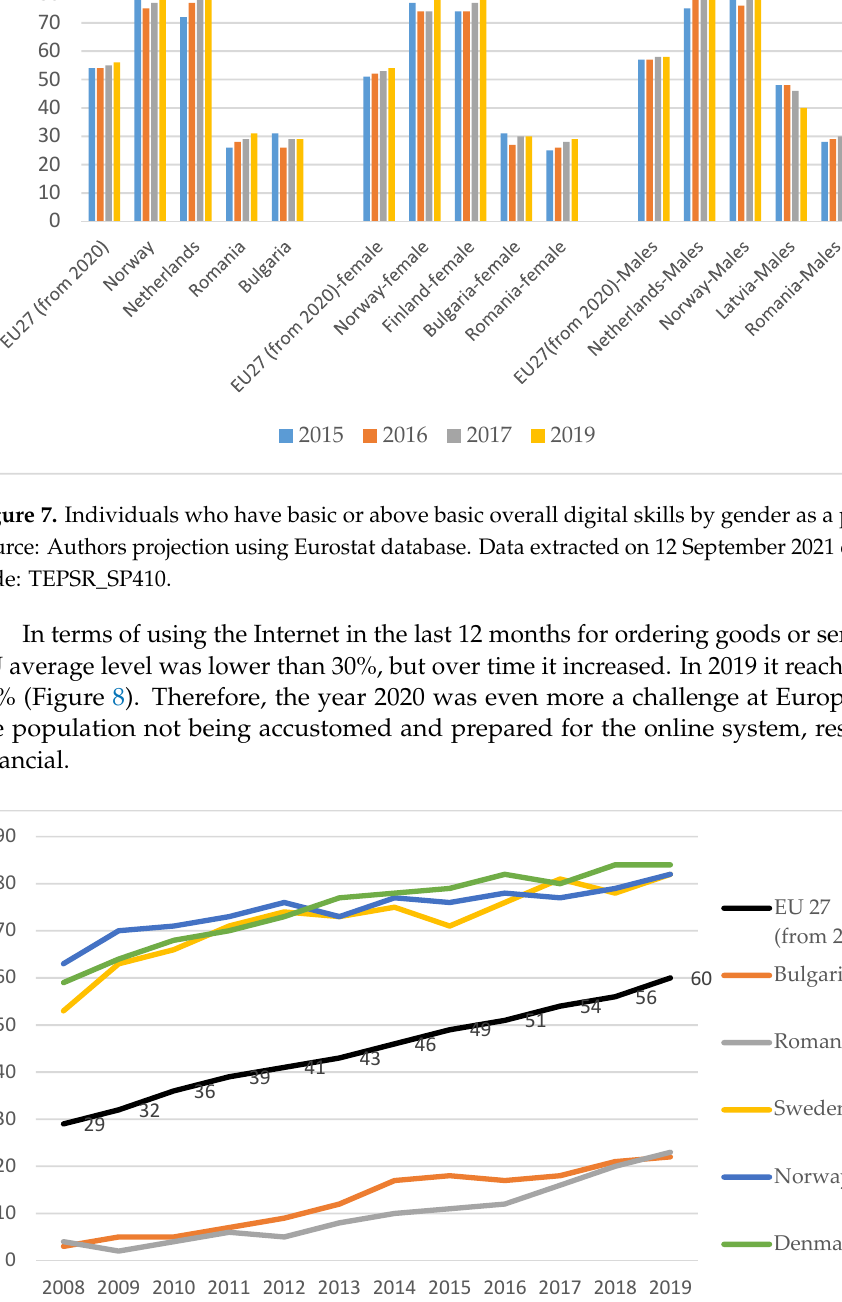
16 of 29 Figure 6. Internet banking—EU 27. Source: Authors projection using Eurostat database. Data ex- tracted on 12 September 2021 online data code: TIN00099. Until the time coronavirus crisis, about 50% of the population was not ready for